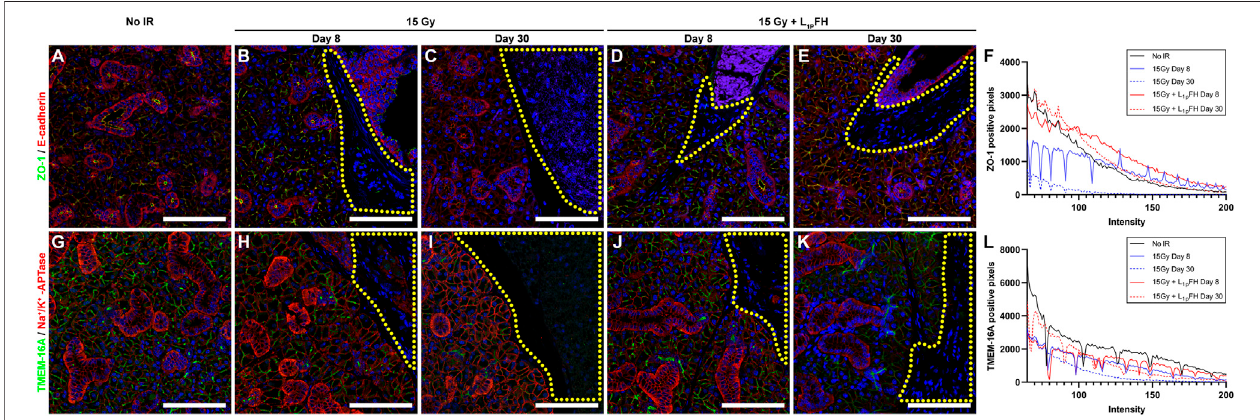
FIGURE 3 | Treatment with L 1p -FH maintains epithelial polarity and functional marker expression. Salivary structural and functional marker organization was analyzed using confocal microscopy with speci fi c antibodies against ZO-1 [green; (A – E) ], E-cadherin [red; (A – E) ], TMEM16A [green; (G – K) ], Na + /K + -ATPase [red; (G – K) ], and DAPI (blue; everywhere). Scale bars represent 100 µm. Yellow-dotted areas indicate fi broblast-like areas. Representative image from a total of fi ve mice per group. ZO-1 (F) and TMEM-16A (L) positive pixels were analyzed using